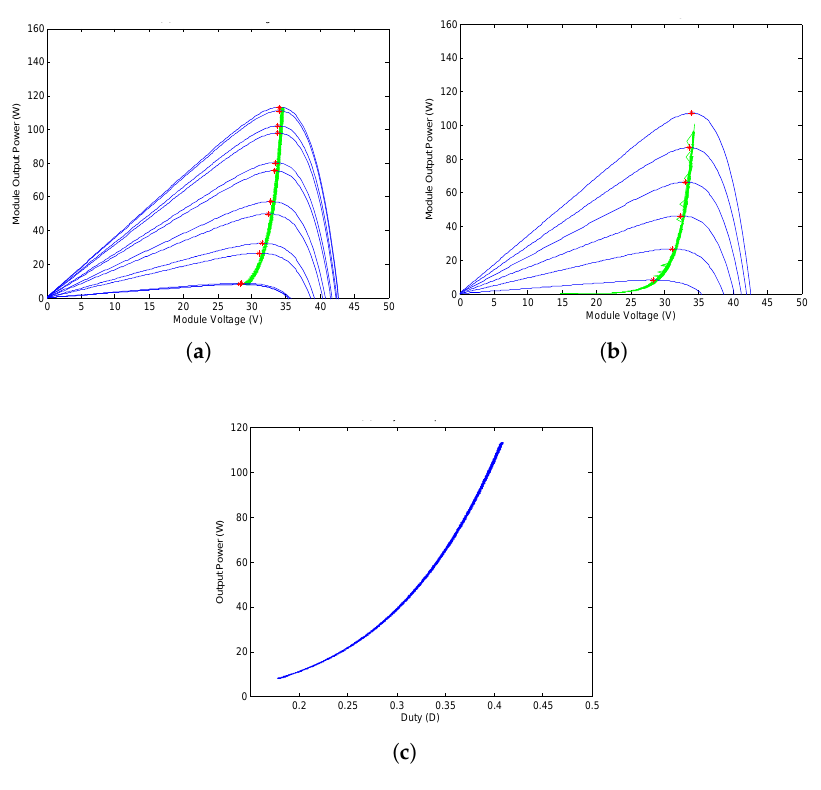
Figure 7. ( a ) Panel voltage vs. power for a sunny day ( b ) Panel voltage vs Power for a Cloudy Day ( c ) Duty vs. Output